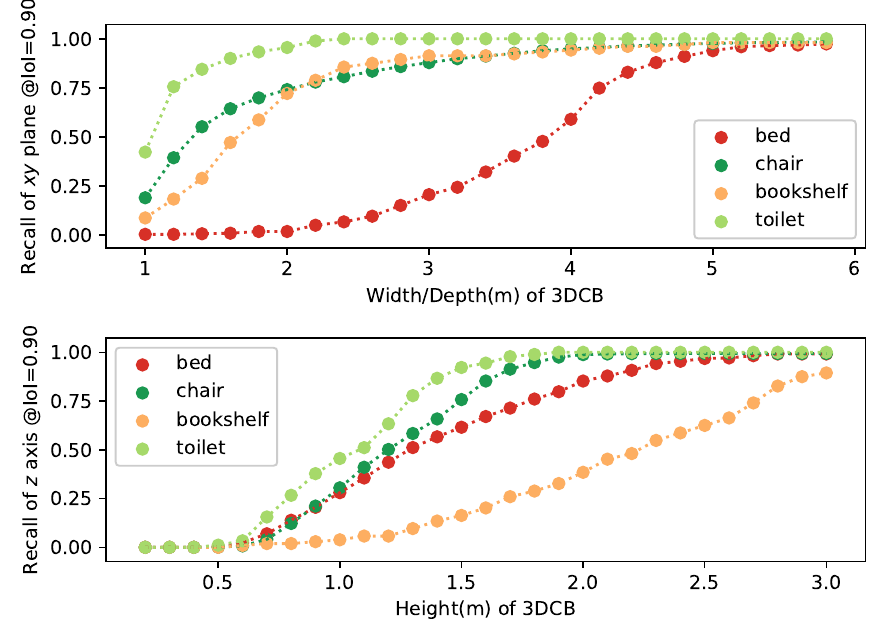
Figure 5. XY plane recall and Z axis recall for bed, chair, bookshelf, and toilet with the widths/depths and heights based on train2666